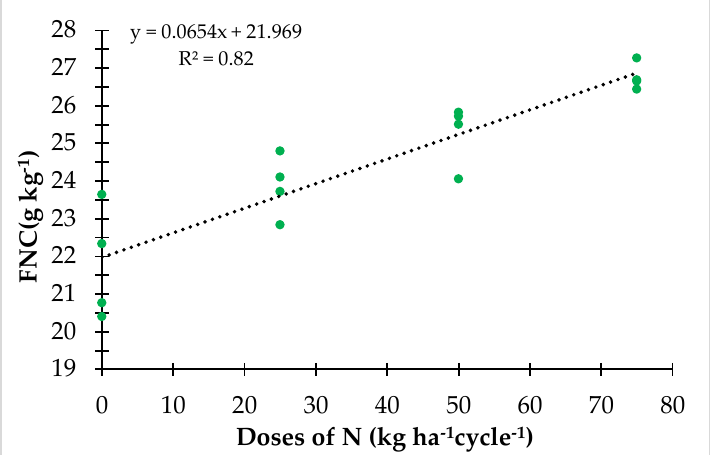
Figure 6. FNC values of Marandu cultivar with different doses of N.